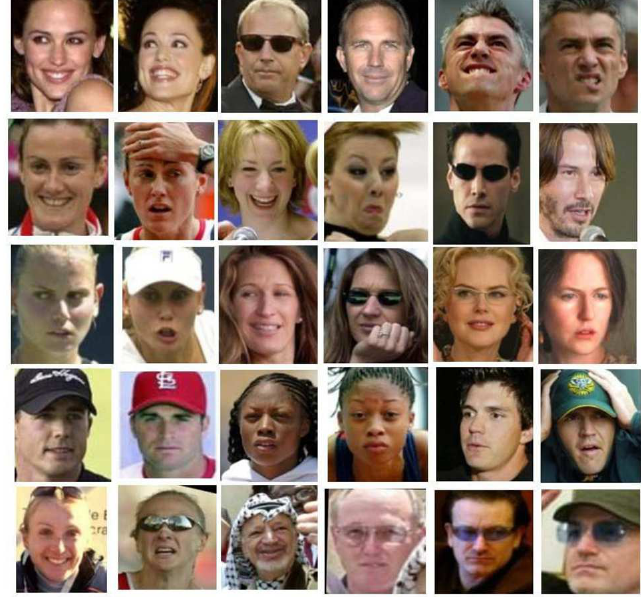
Figure 20. The pairs falsely rejected by the proposed